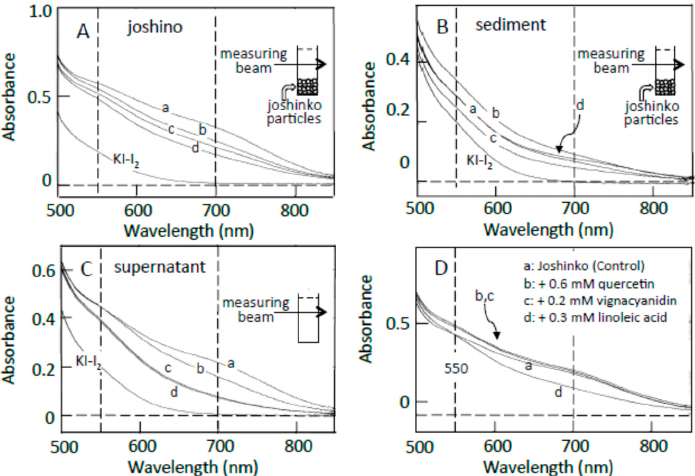
Figure 2. Effects of adzuki extract on the formation of starch-iodine complexes. ( A ) retrograding